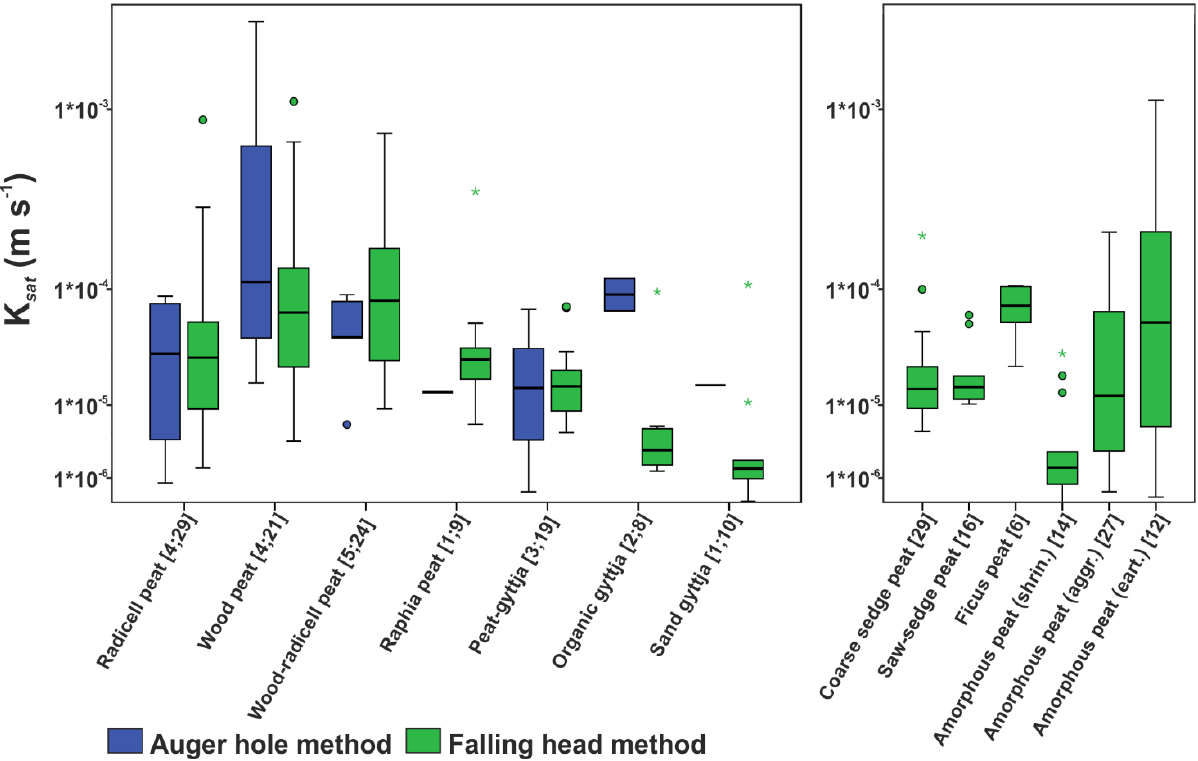
Figure 6. Saturated hydraulic conductivities ( K substrates measured in the laboratory and in the field; right: K laboratory only. The X-axis indicates substrates with number(s) of samples in square